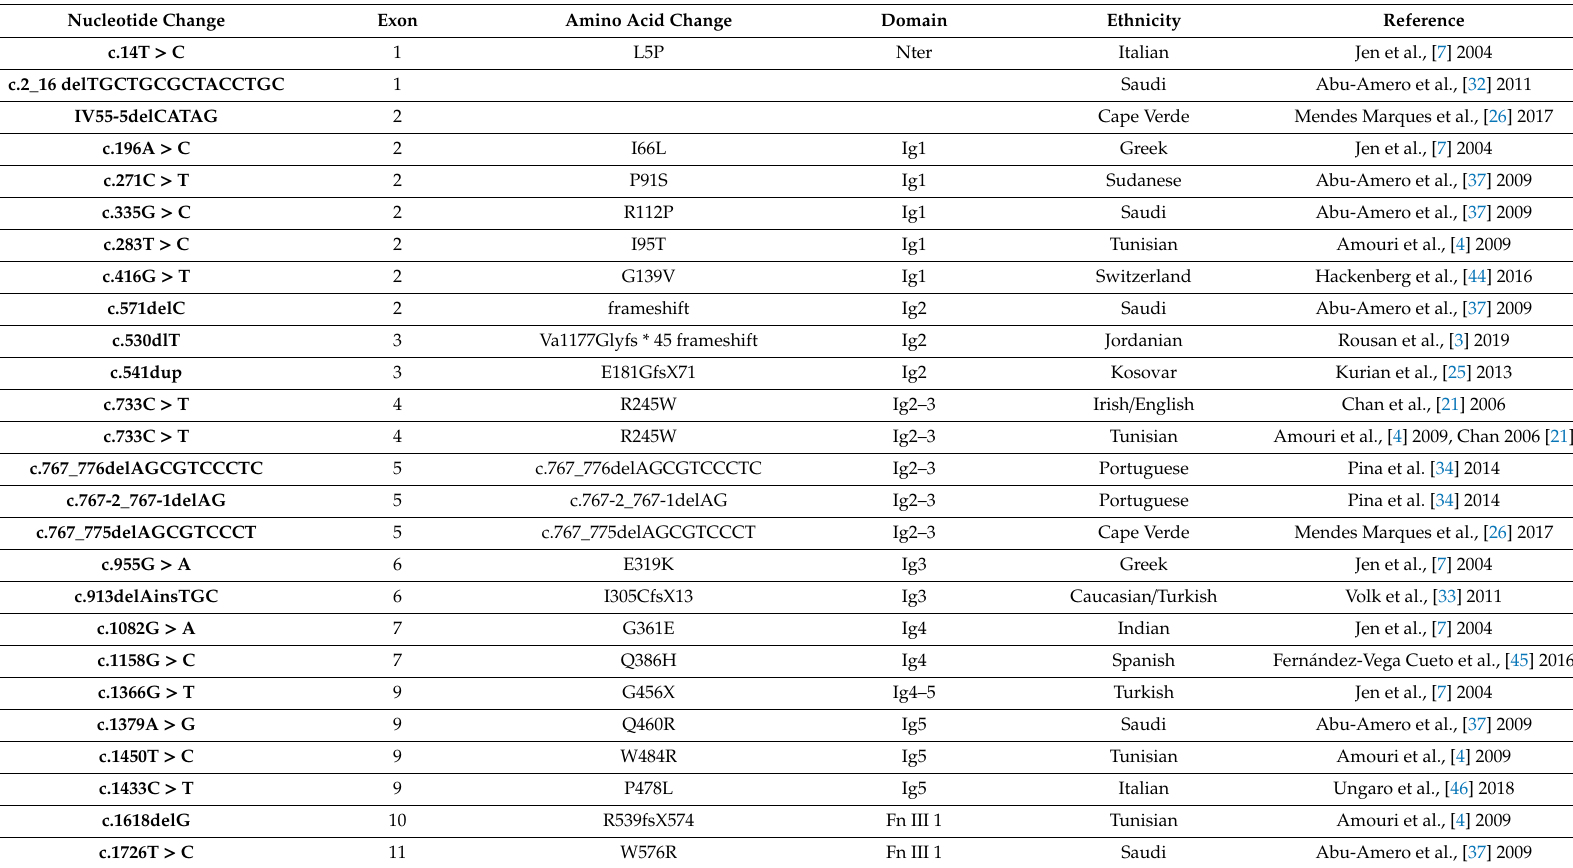
Table 3. Mutations in ROBO 3 gene linked to HGPPS to date. Missense, nonsense, frameshift, and splice site mutations leading to premature stop codon and potentially truncated